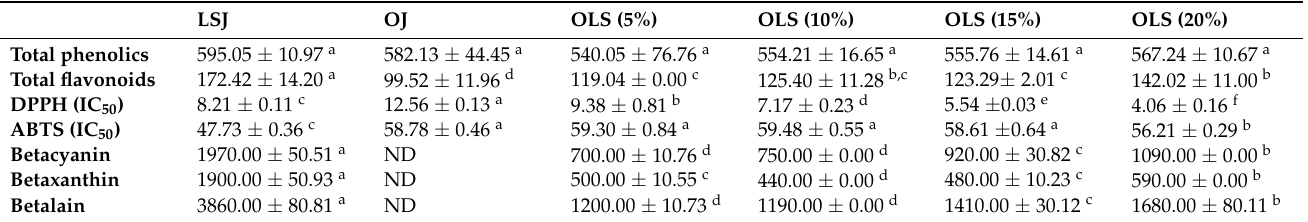
Table 5. Bioactive components and antioxidant activity of orange juice mixed with beetroot stem–leaf juice in different proportions ( µ